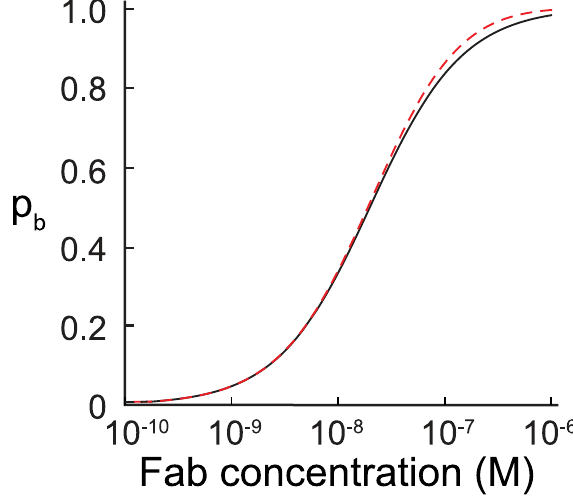
Figure 3. Comparison of the predictions for p b of the model in the low concentration limit that allows only one Fab to bind per spike (red dashed curve) with the model that allows up to three Fab to bind per spike (solid black curve). The parameters are from Table 1 for 4E10 Fab with l ~ 0 : 001 s { 1 .